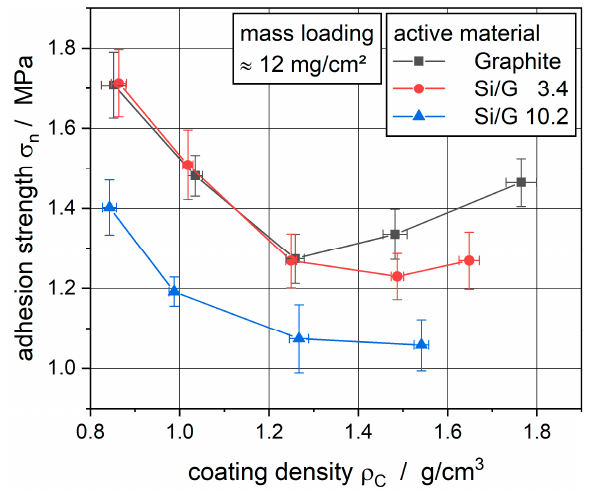
Figure 3. The adhesion strength between coating and current collector at different coating